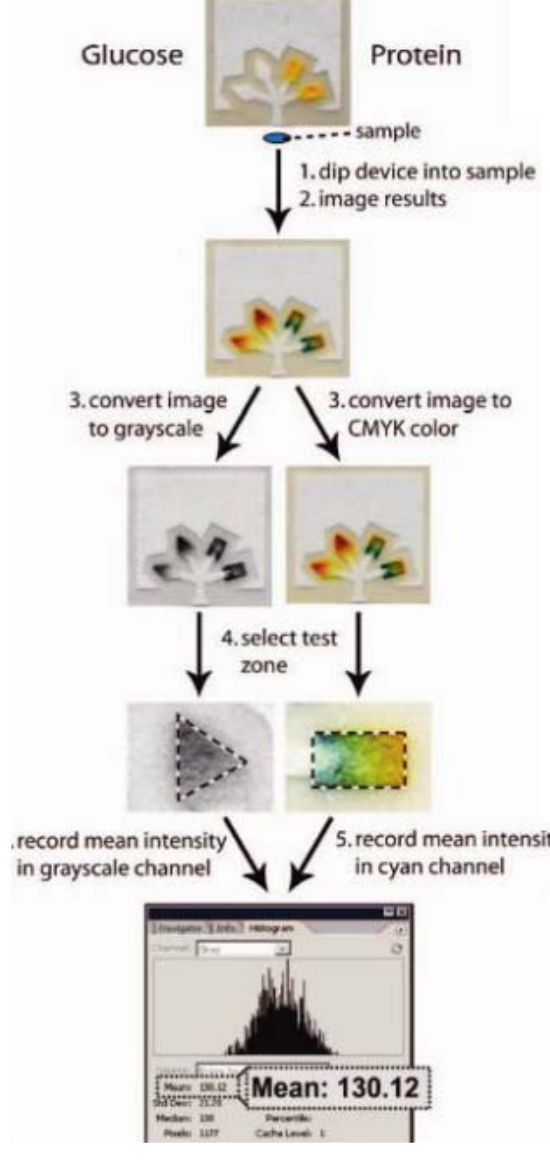
Figure 5. Procedure for quantifying the amount of glucose and protein in a urine sample using Adobe ® Photoshop ® by converting the images into greyscale (for glucose assay analysis) and CMYK colour (for protein assay analysis) to obtain the mean pixel values in the test zones which correlates to the concentration of the analytes in the